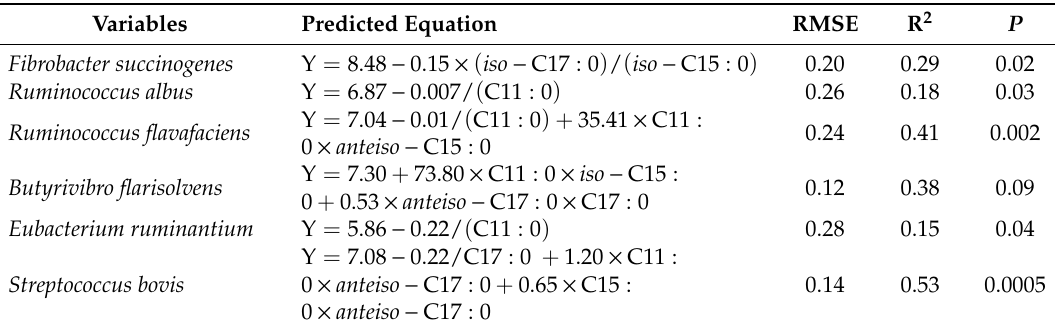
Table 10. Predicted equations of ruminal bacterial populations (log 10 copies / mL) from milk OBCFA. Variables Predicted Equation